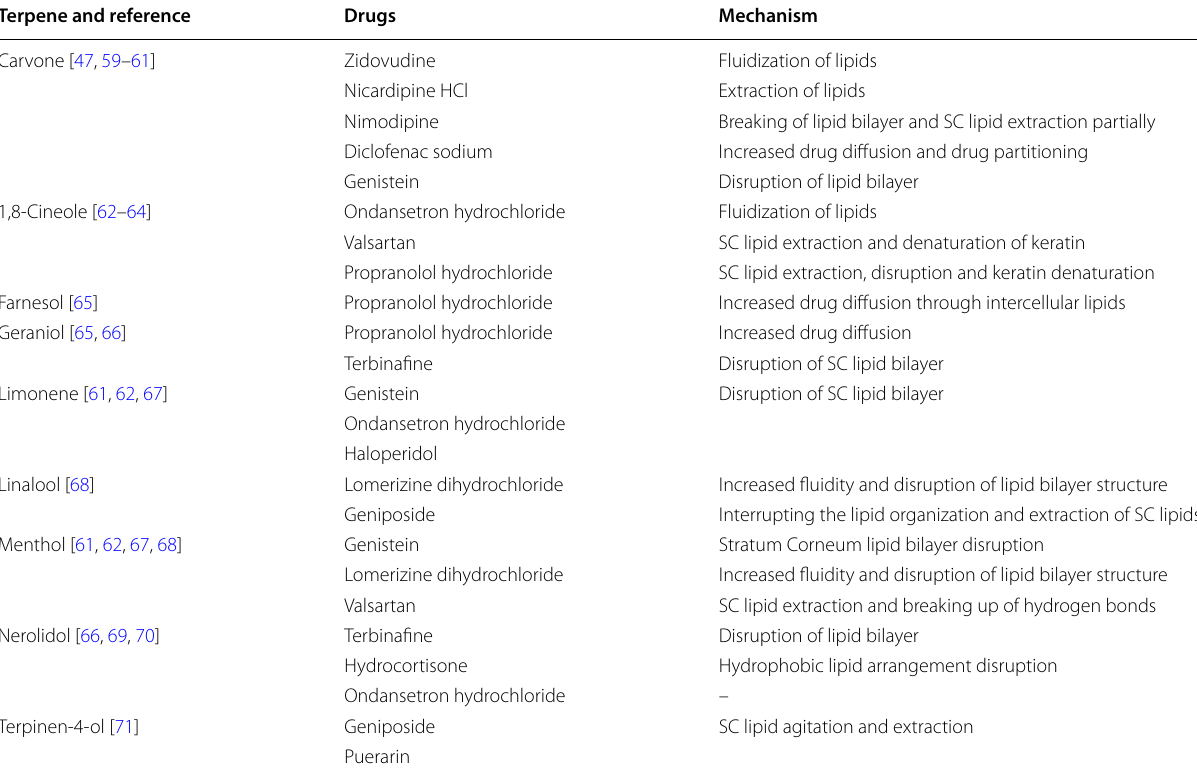
Table 3 Application of terpenes in penetration enhancement Terpene and